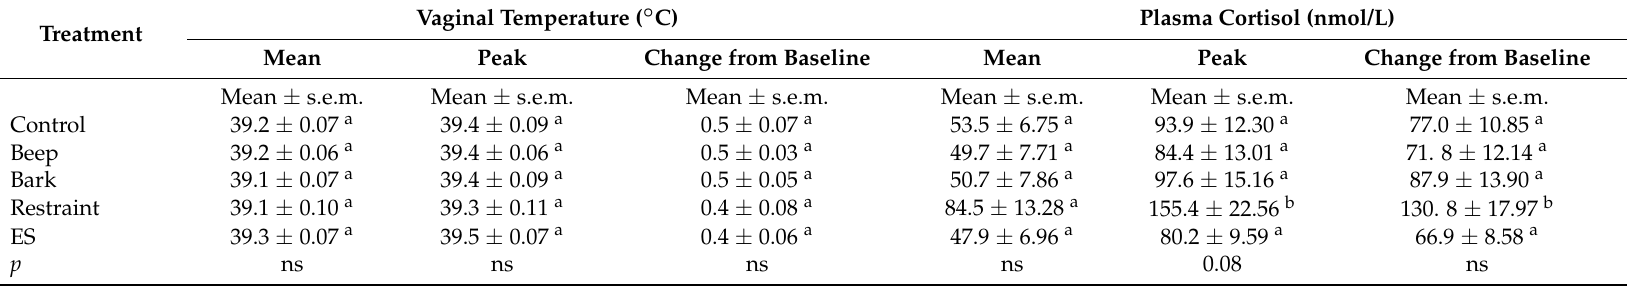
Table 2. Mean, peak and change from baseline ( ± s.e.m) vaginal temperature and plasma cortisol measurements in the 60 min following treatment. Significant effects are as compared to control treatment. ES = electrical stimulus